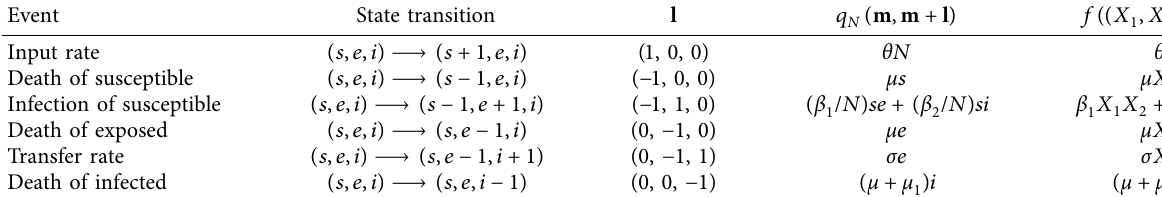
( t ) : t ≥ 0 􏼈 􏼉 at time t N